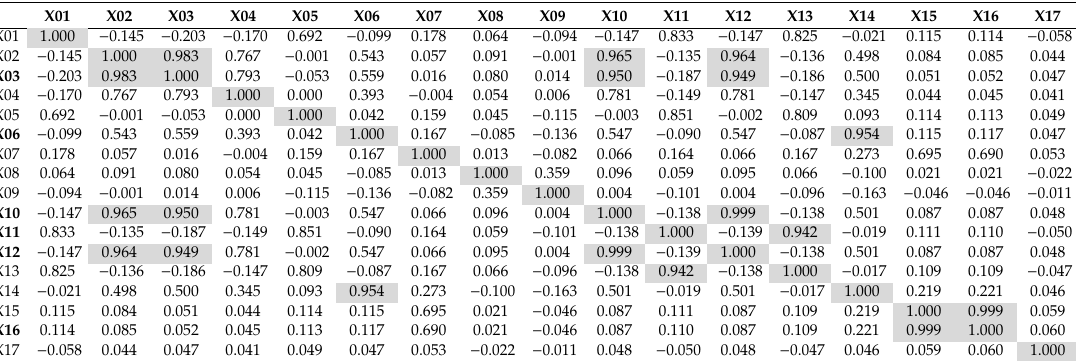
Table 5. Results of correlation analysis ( (cid:4) strongly correlated variables, cuto ff = 0.9).